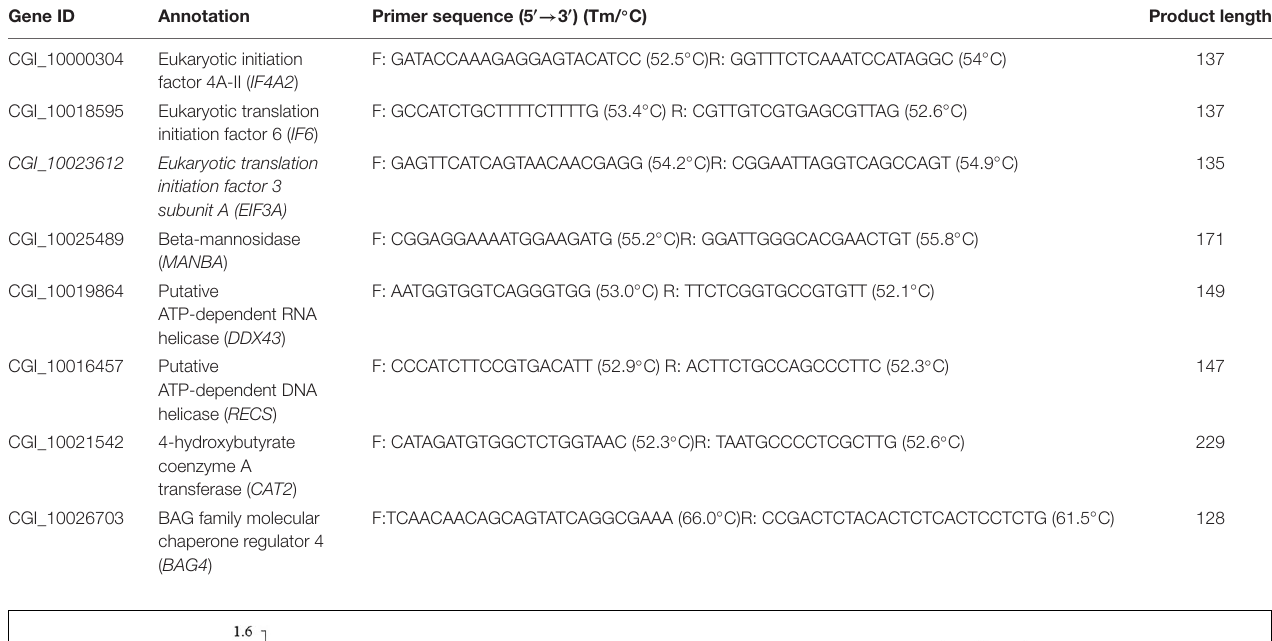
TABLE 4 | The genes with differential expression level between selected and control oysters and the primers used for q-PCR quantification.